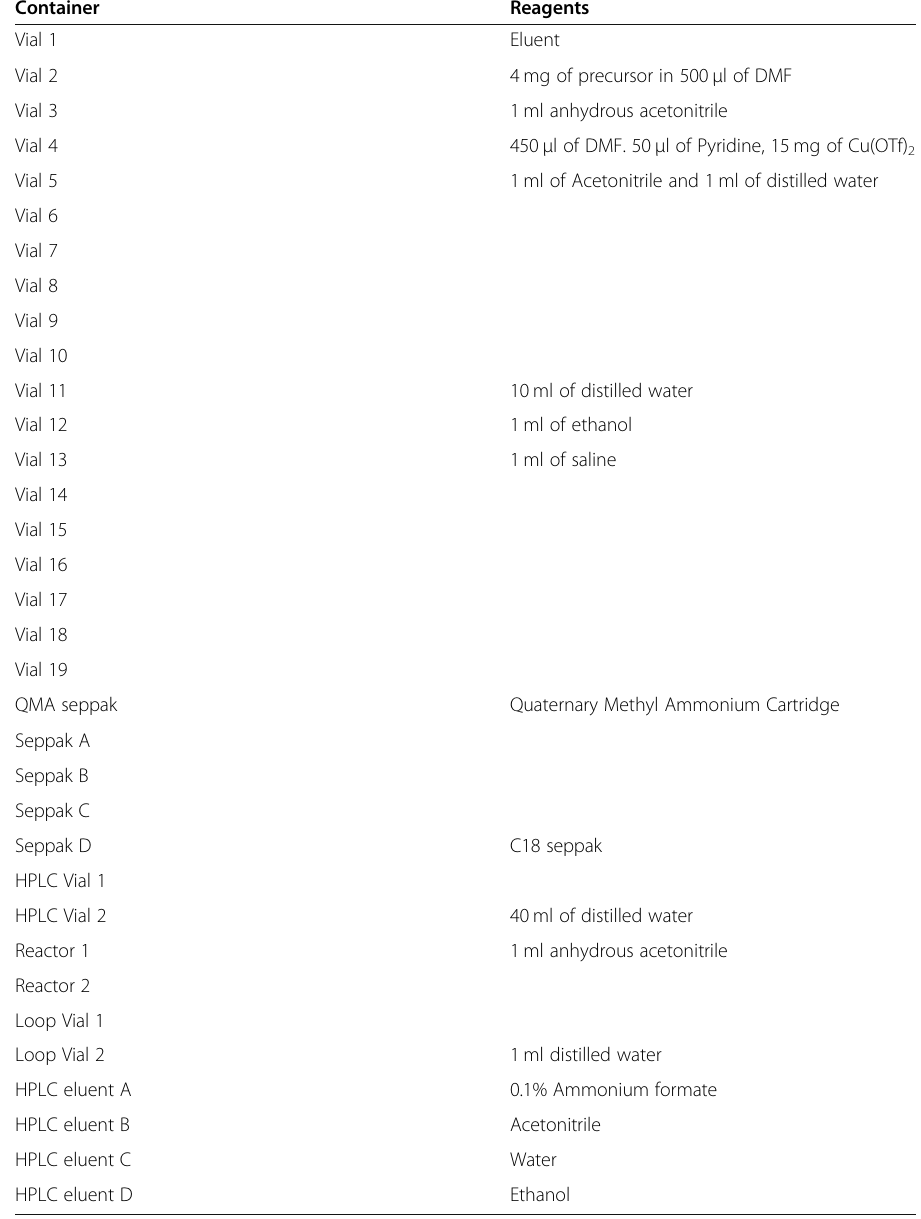
Table 1 Flexlab set up for radiolabelling reactions